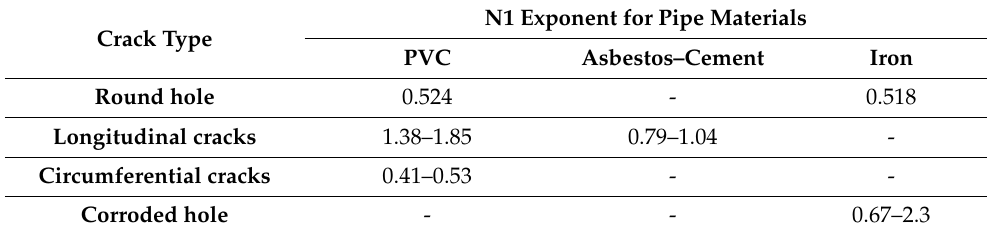
Table 1. Leak exponents obtained by Greyvenstein and van Zyl research [8].